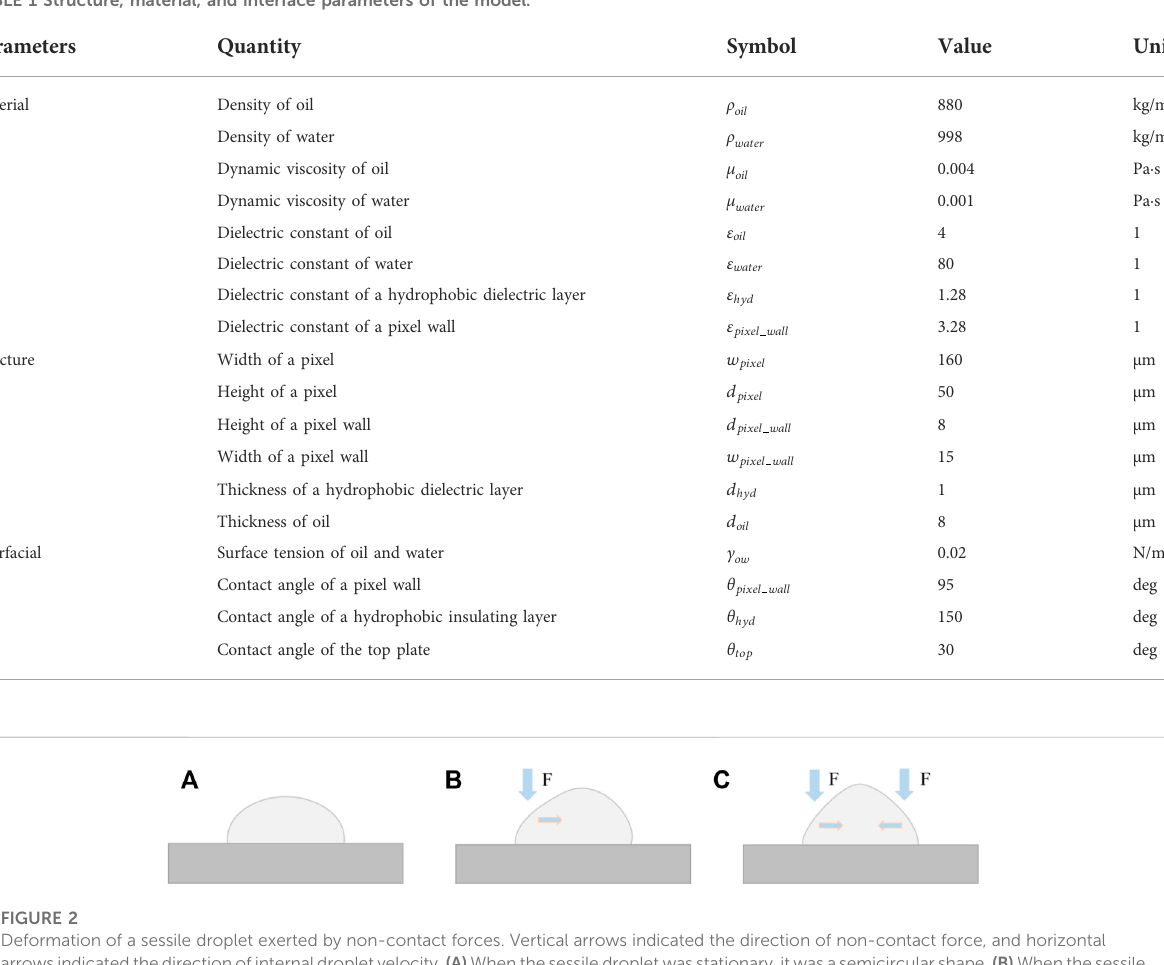
TABLE 1 Structure, material, and interface parameters of the model.